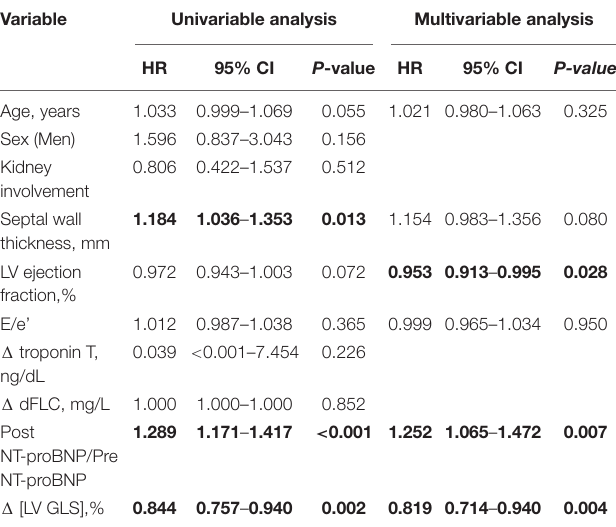
TABLE 3 | Univariable and multivariable Cox analysis of 5-year all-cause death risk according to clinical characteristics, biomarkers and echocardiographic parameters.